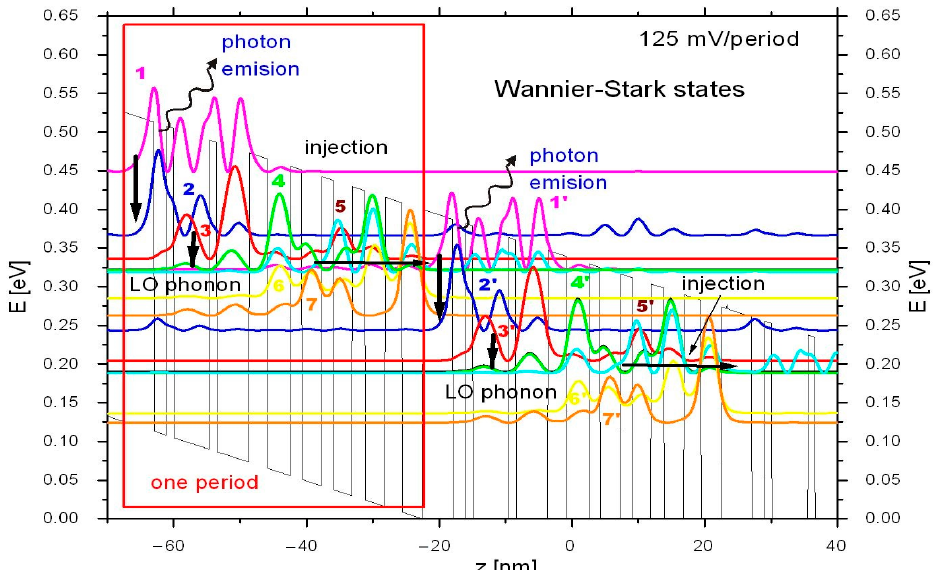
Figure 6. The base of Warnier–Stark functions (WSF) calculated for the SL structure no. 3. described in [3] for the voltage of the 125 mV/period with electron transitions marked.